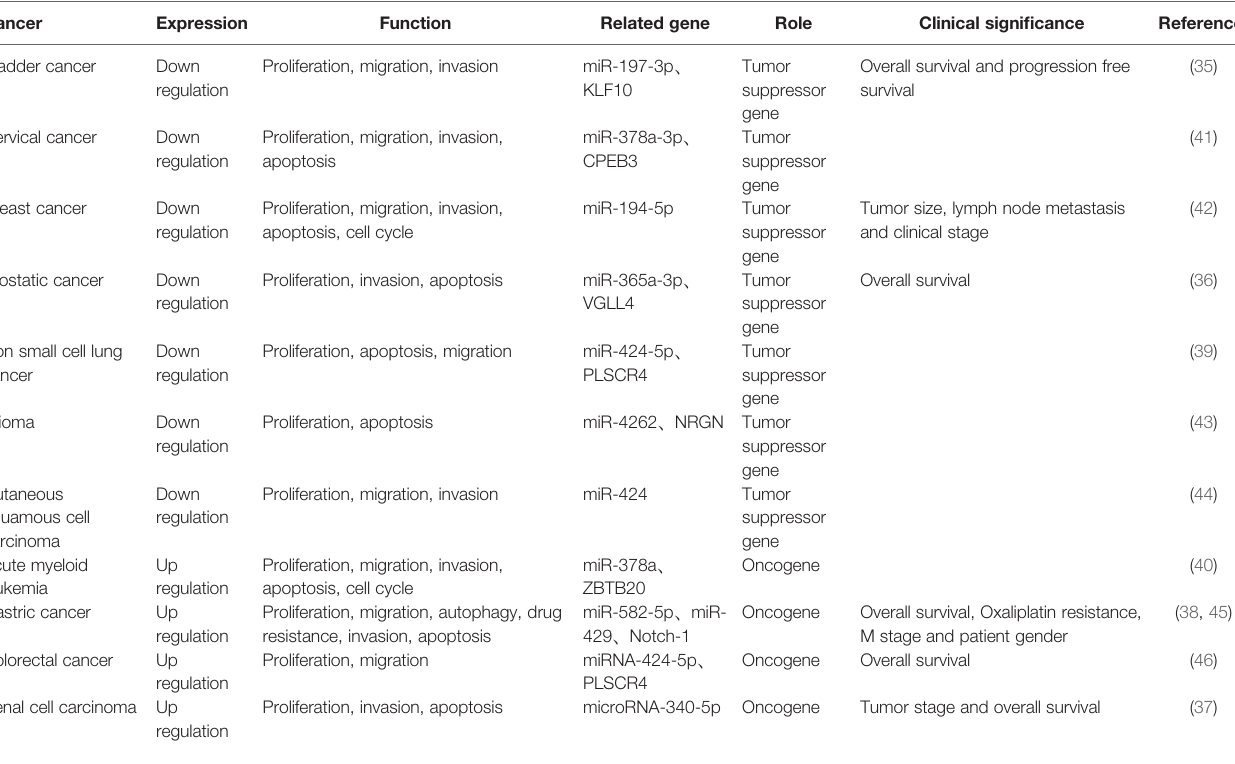
TABLE 1 | Functional characteristics and clinical signi fi cance of LINC00641 in different cancers.